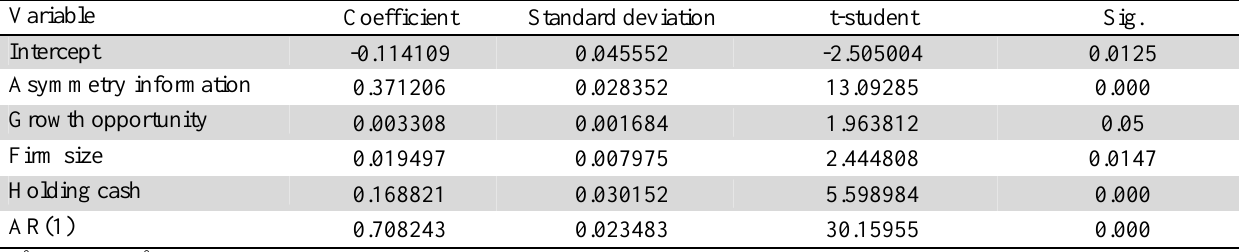
The results of regression analysis